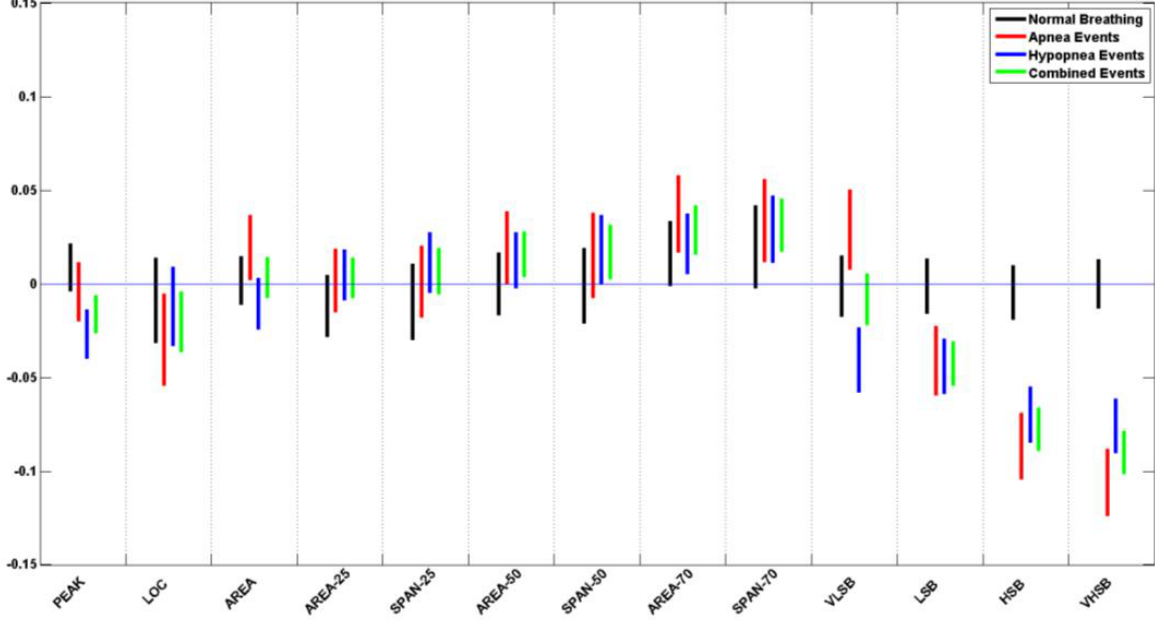
Figure 11. Ratio of standard deviation (RS) CI plots for all 13 features of the pooled data from all subjects.